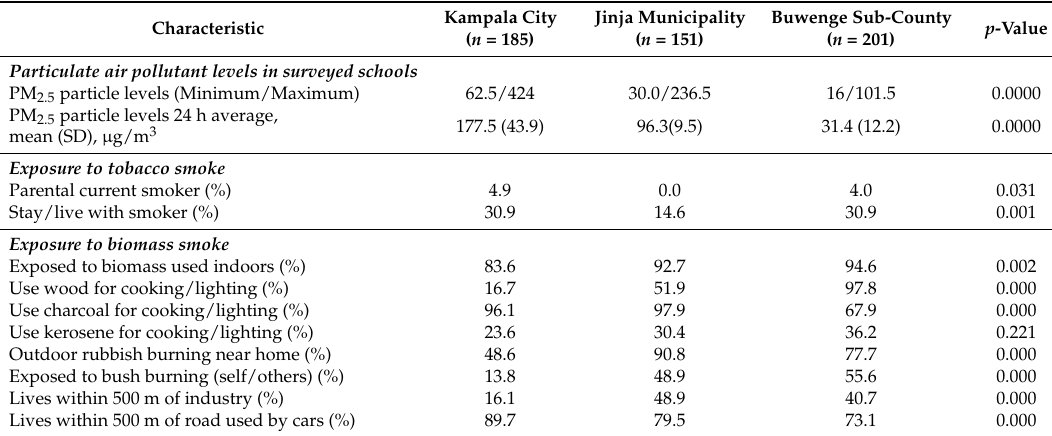
Table 2. Air pollution exposures by